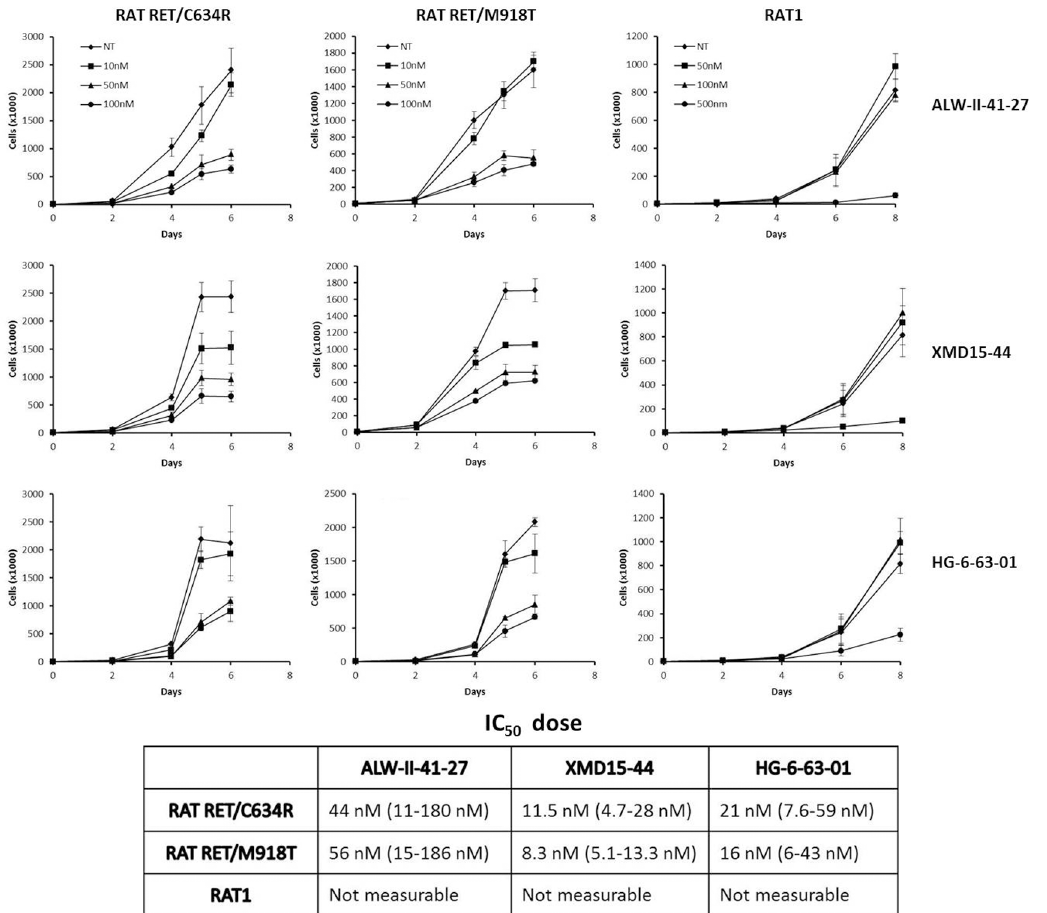
Fig 3. Growth inhibitory effects of ALW-II-41-27, XMD15-44 and HG-6-63-01 in RAT1 cells transformed by RET/C634R and RET/M918T. Top) Parental or RET/C634R and RET/M918T RAT1 cells were incubated in low serum with vehicle (NT: not treated) or the indicated concentrations of ALW-II-41-27, XMD15-44 and HG-6-63-01 and counted at the indicated time points. Data are the mean ± SD of two experiments performed in triplicate. Bottom) Growth inhibition IC 50 of ALW-II-41-27, XMD15-44 and HG-6-63-01 for the different cell lines; 95% confidence intervals (CI) are indicated in brackets.